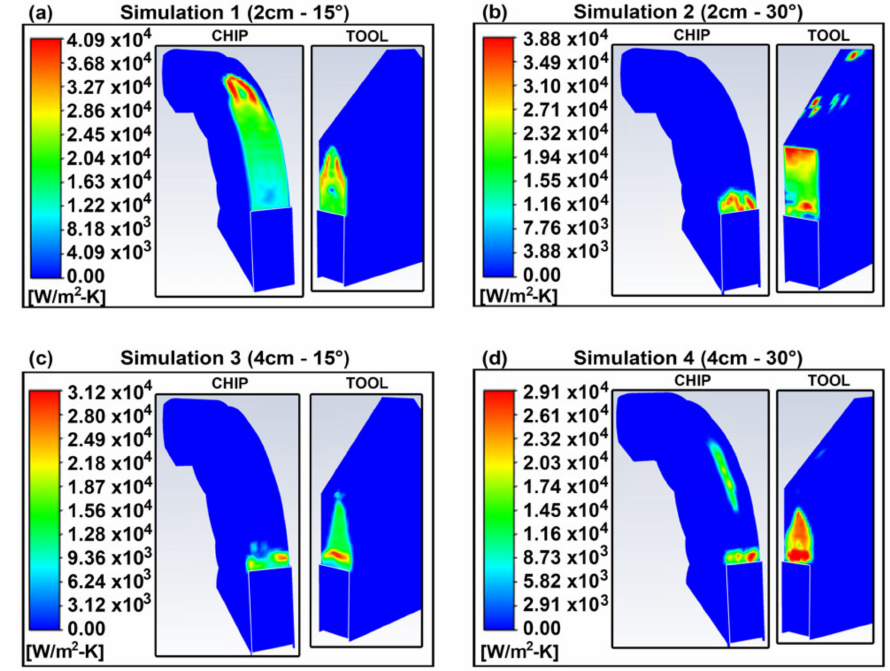
Figure 6. Heat convection coefficient profiles (in W/m 2 -K).